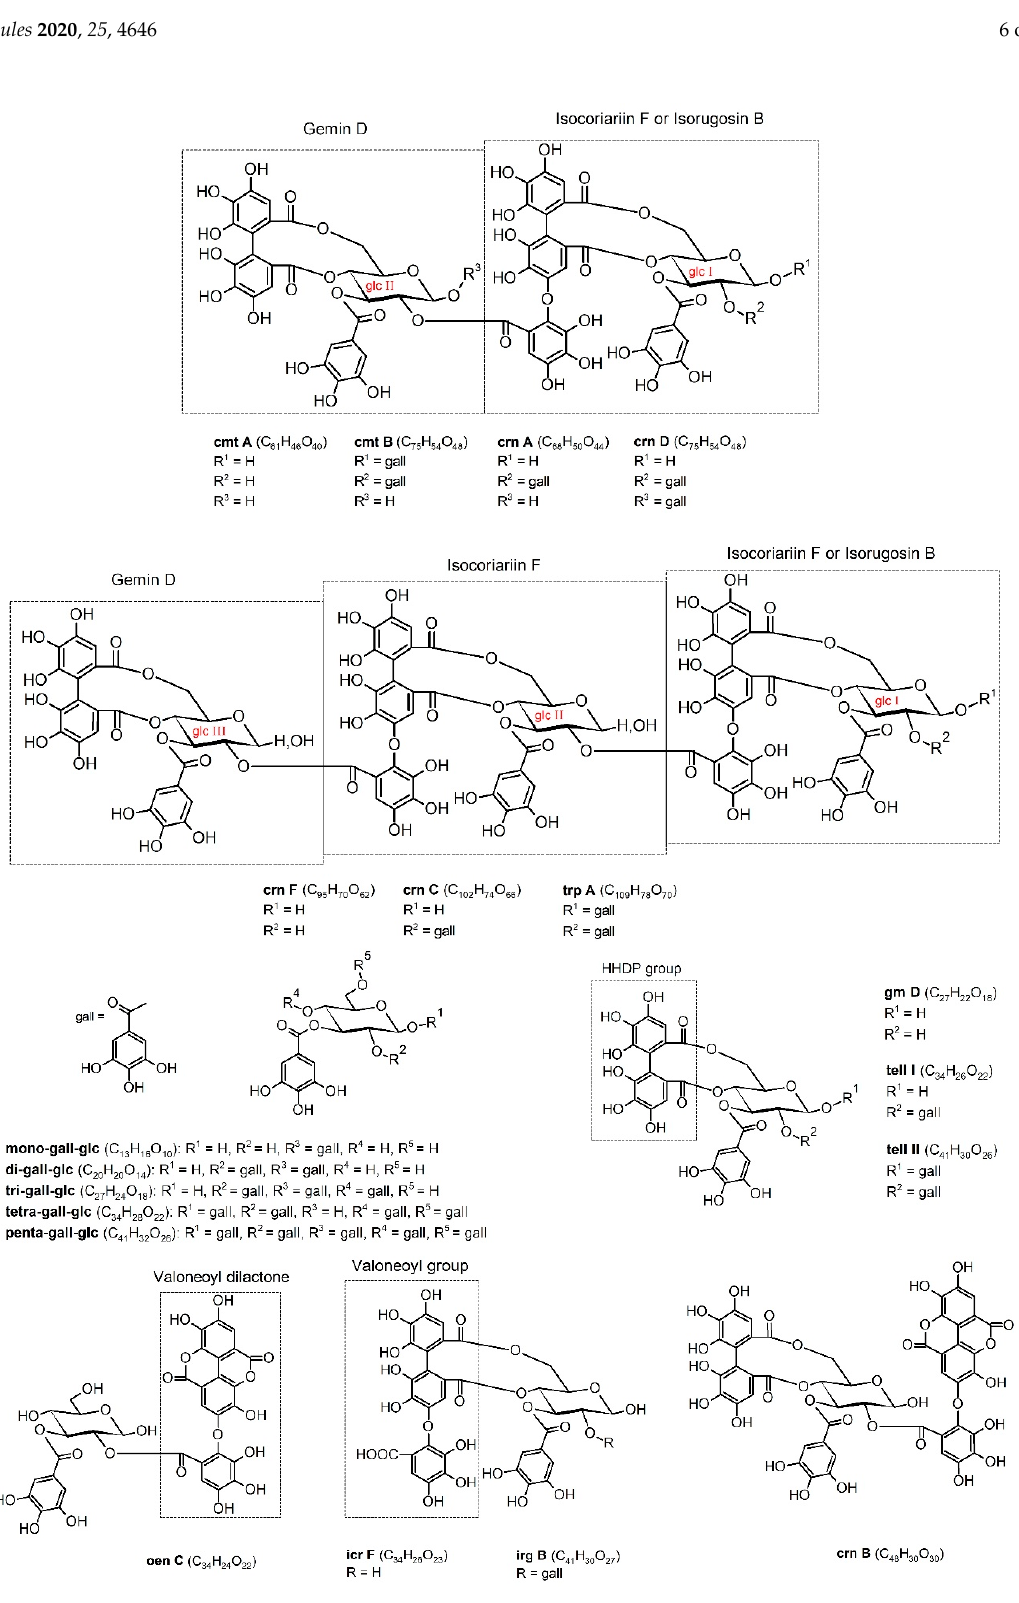
Figure 2. Chemical structures of the identified hydrolyzable tannins. Abbreviations: gall, galloyl; glc, β - D -glucose; gm D, gemin D; tell I, tellimagrandin I; tell II, tellimagrandin II; oen C, oenothein C; icr F, isocoriariin F; irg B, isorugosin B; crn B, cornusiin B; cmt A, camptothin A; cmt B, camptothin B; crn A, cornusiin A; crn D, cornusiin D; crn F, cornusiin F; crn C, cornusiin; trp A, trapanin A.